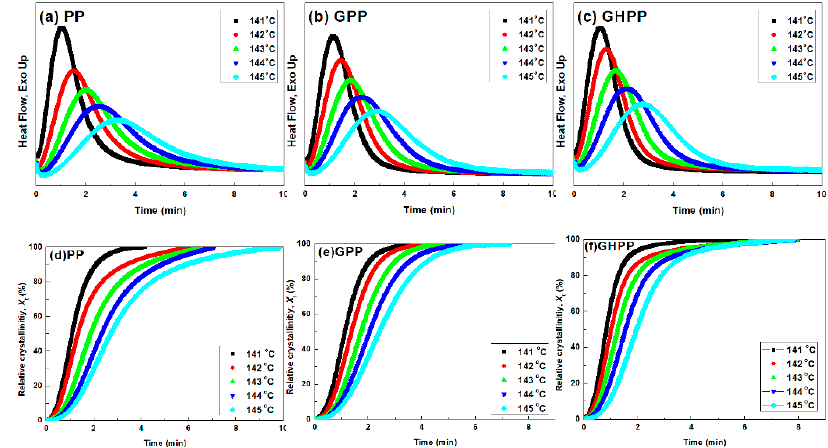
Figure 7. Self-nucleation isothermal crystallization curves ( a ) neat PP, ( b ) GPP and ( c ) GHPP and plots of relative crystallinity vs. crystallization time for ( d ) neat PP, ( e ) GPP and ( f ) GHPP when self-nucleated at 167 ◦ C for 5 min and subsequently isothermally crystallized at T cSN = 141–145 ◦ C.